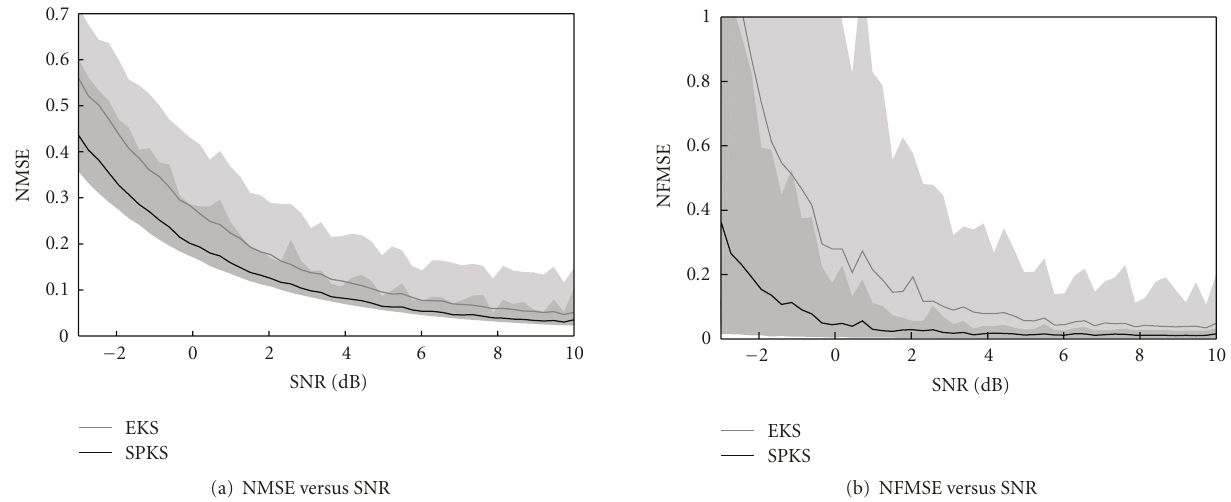
Figure 3: (a) NMSE versus SNR (b) NFMSE versus SNR. In the plots the shaded regions represent the 5th and 95th percentile ranges of the NFMSE and NMSE, respectively.